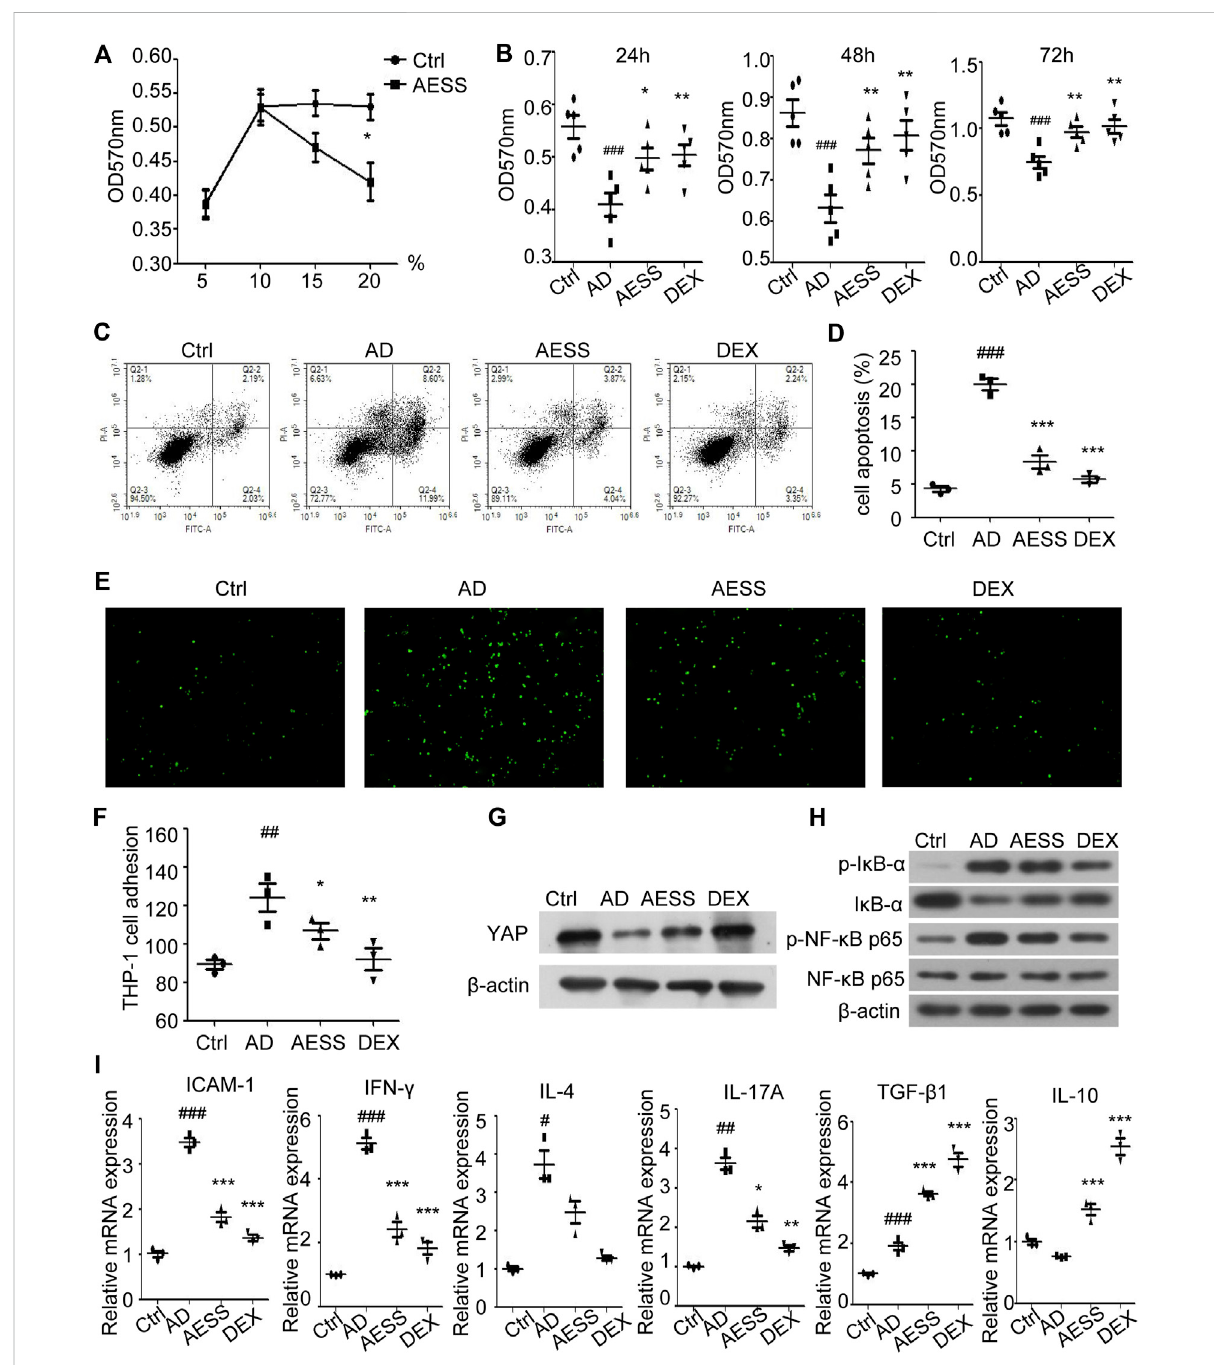
FIGURE 5 AESS contained serum can improve proliferation, reduce apoptosis of AD-like cell model and reduce adhesion rate to THP-1 cells. (A) Determination of AESS contained serum concentration in rats by MTT. (B) Cell proliferation was examined 24 h after culture with AESS contained serumbyMTT (C,D) Apoptosiswasexamined24 hafterculturewithAESScontainedserumbyFACSanalysis. (E,F) AdhesionofAD-likecellstoTHP-1 cells 24 h after culture with AESS contained serum (100 ×). (G) YAP expression after culture with AESS contained serum. (H) I κ B- α , p-I κ B- α , NF- κ B p65and p-NF- κ B p65 expression after culture with AESS contained serum. (I) ICAM-1 and in fl ammatory cytokines (IFN- γ , IL-4, IL-17A, TGF- β and IL-10)mRNAexpression.MTTfor fi vereplicates. Cellapoptosis, adhesion assayandqRT-PCRforthree replicates.Ctrl:ControlHaCaTcells;AD:AD- like cells were established by HaCaT cells culture with 10 ng/ml TNF- α /IFN- γ ; AESS: AD-like cells culture with AESS contained serum; DEX: AD-like cells culture with 20 μ g/ml dexamethasone. # p < 0.05, ## p < 0.01, ### p < 0.001 v. s. Ctrl; * p < 0.05, ** p < 0.01, *** p < 0.001 v. s.